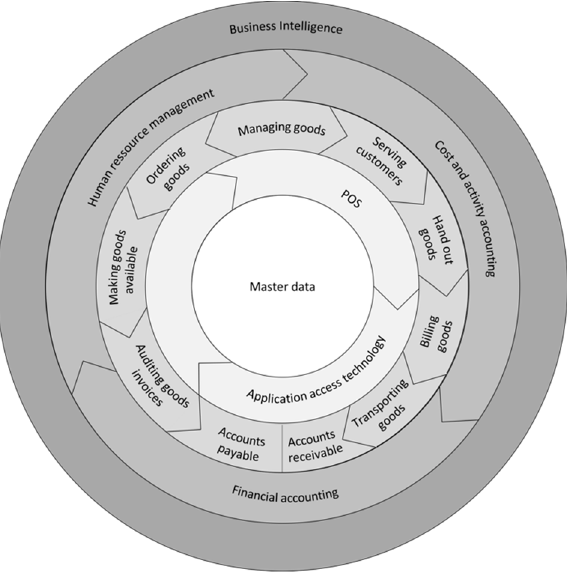
Figure 1. Retail Information system architecture shell model [1].